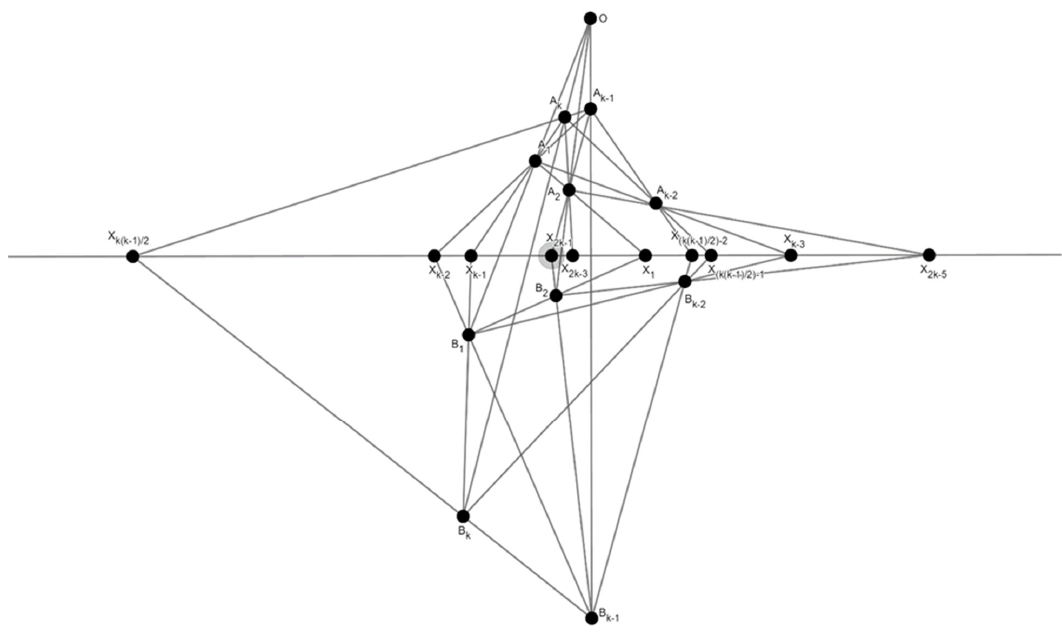
Figure 4. Perspectivity of two n-points from a point.